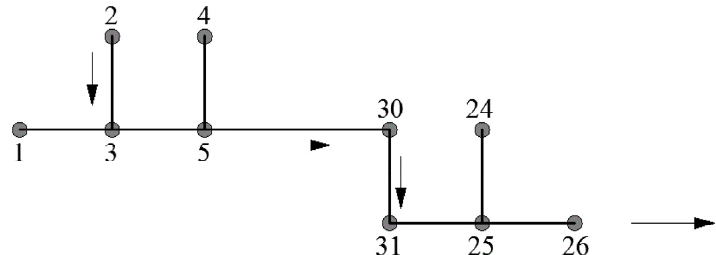
Figure 2. World Bank (1991) [61] case study.